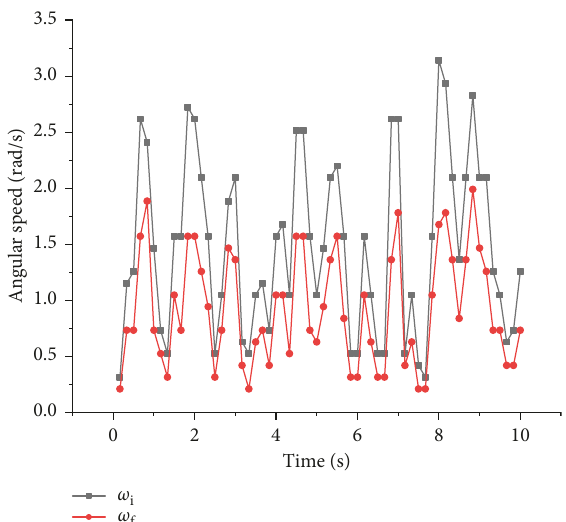
Figure 17: Angular speeds of the sleeve (with 4 rollers) and the shaft.